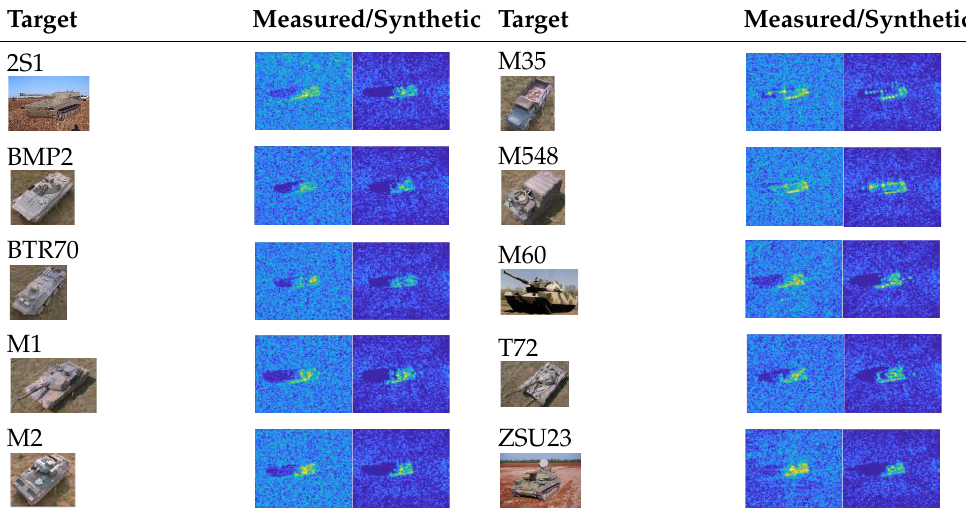
Figure 1. Clutter backgrounds have a great effect on target classification accuracy.